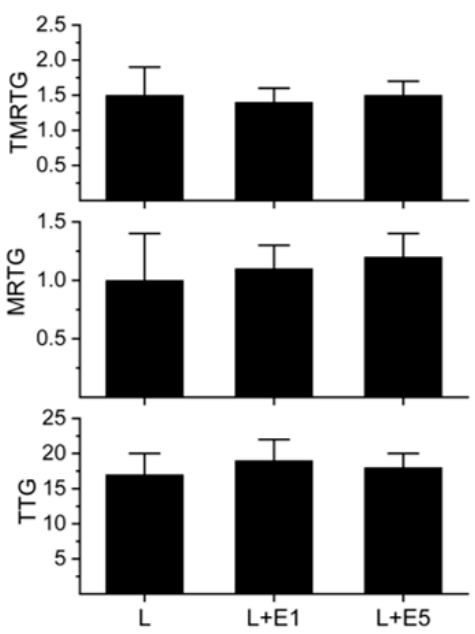
Figure 4. T he effects of exposure of the LAAO to ethylenediaminetetraacetic acid (EDTA). The data are displayed as the mean ± SD. TMRTG = minutes; MRTG = dynes/cm 2 /sec; TTG = dynes/cm 2 . L = plasma with 500 nM LAAO addition; L + E1 = LAAO exposed to 1 mM EDTA; L + E5 = LAAO exposed to 5 mM EDTA.